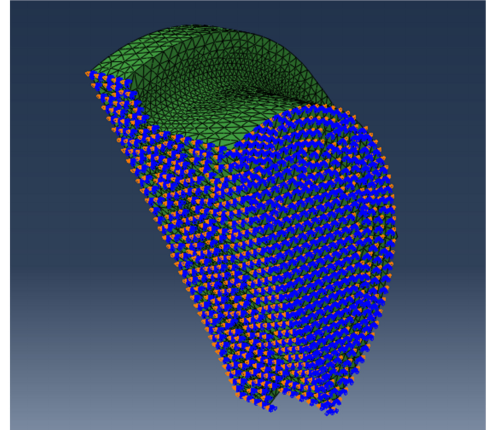
Figure 12. Displacement boundary conditions of the crankshaft.